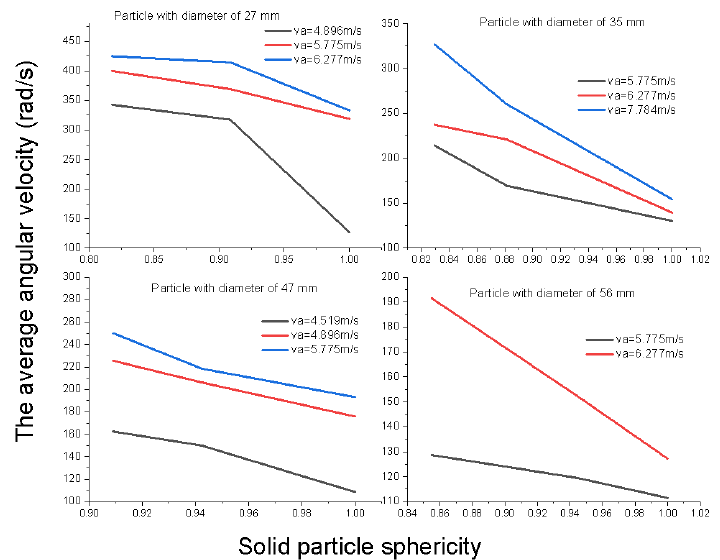
Figure 3. The variation of the angular average velocity on function by the variation of the airflow velocity and the variation of the solid particle shape for particles of different sizes [19,43]. [Reprinted/adapted with permission from Ref. [19]. Ristea M, 2020. [43]].